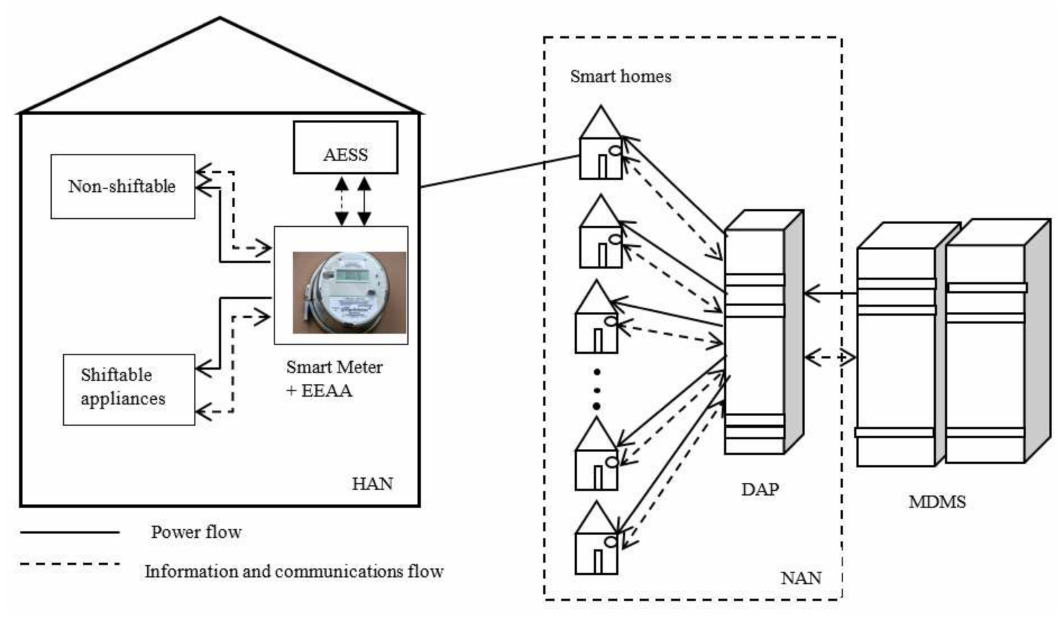
Figure 1. Illustration of energy expenditure affordability algorithm (EEAA) architecture in a smart